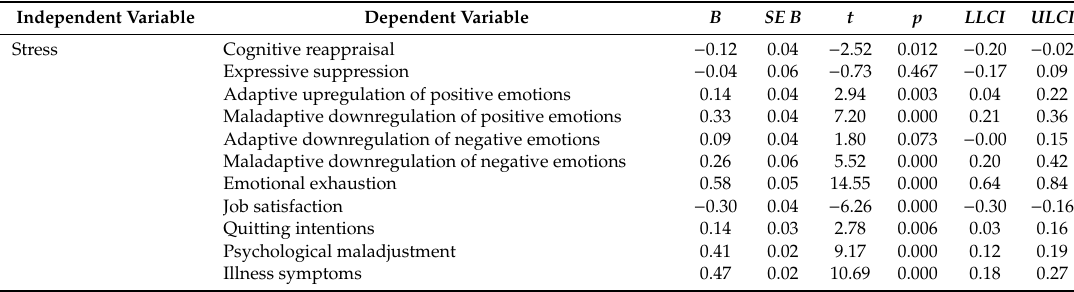
Table 5. Main E ff ects of Stress on Emotion regulation Strategies and